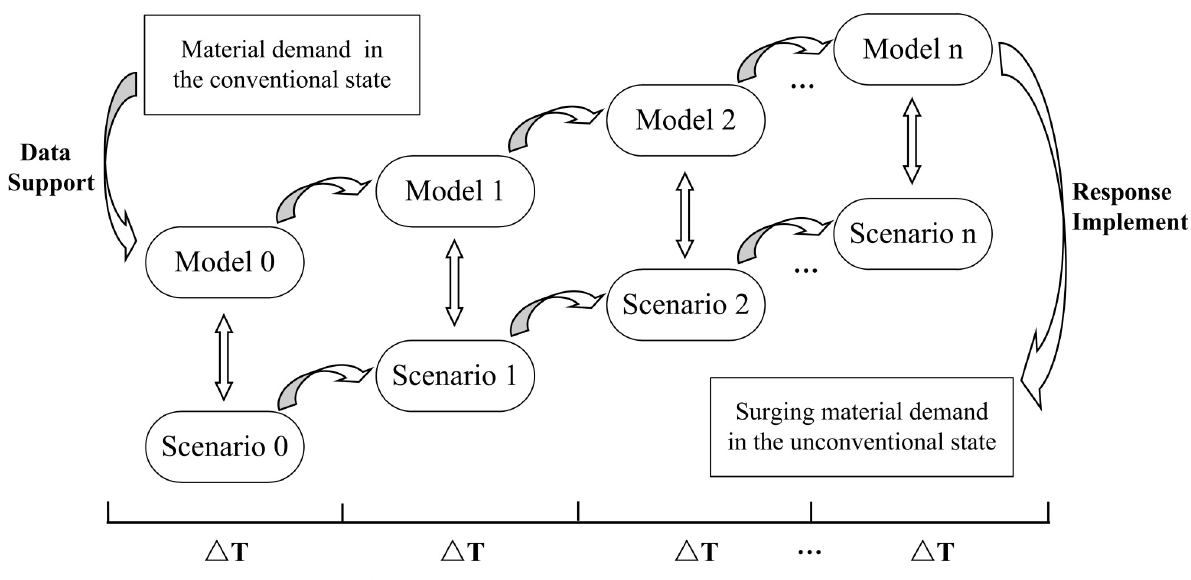
Fig 4. Parallel implementation mechanism for surging